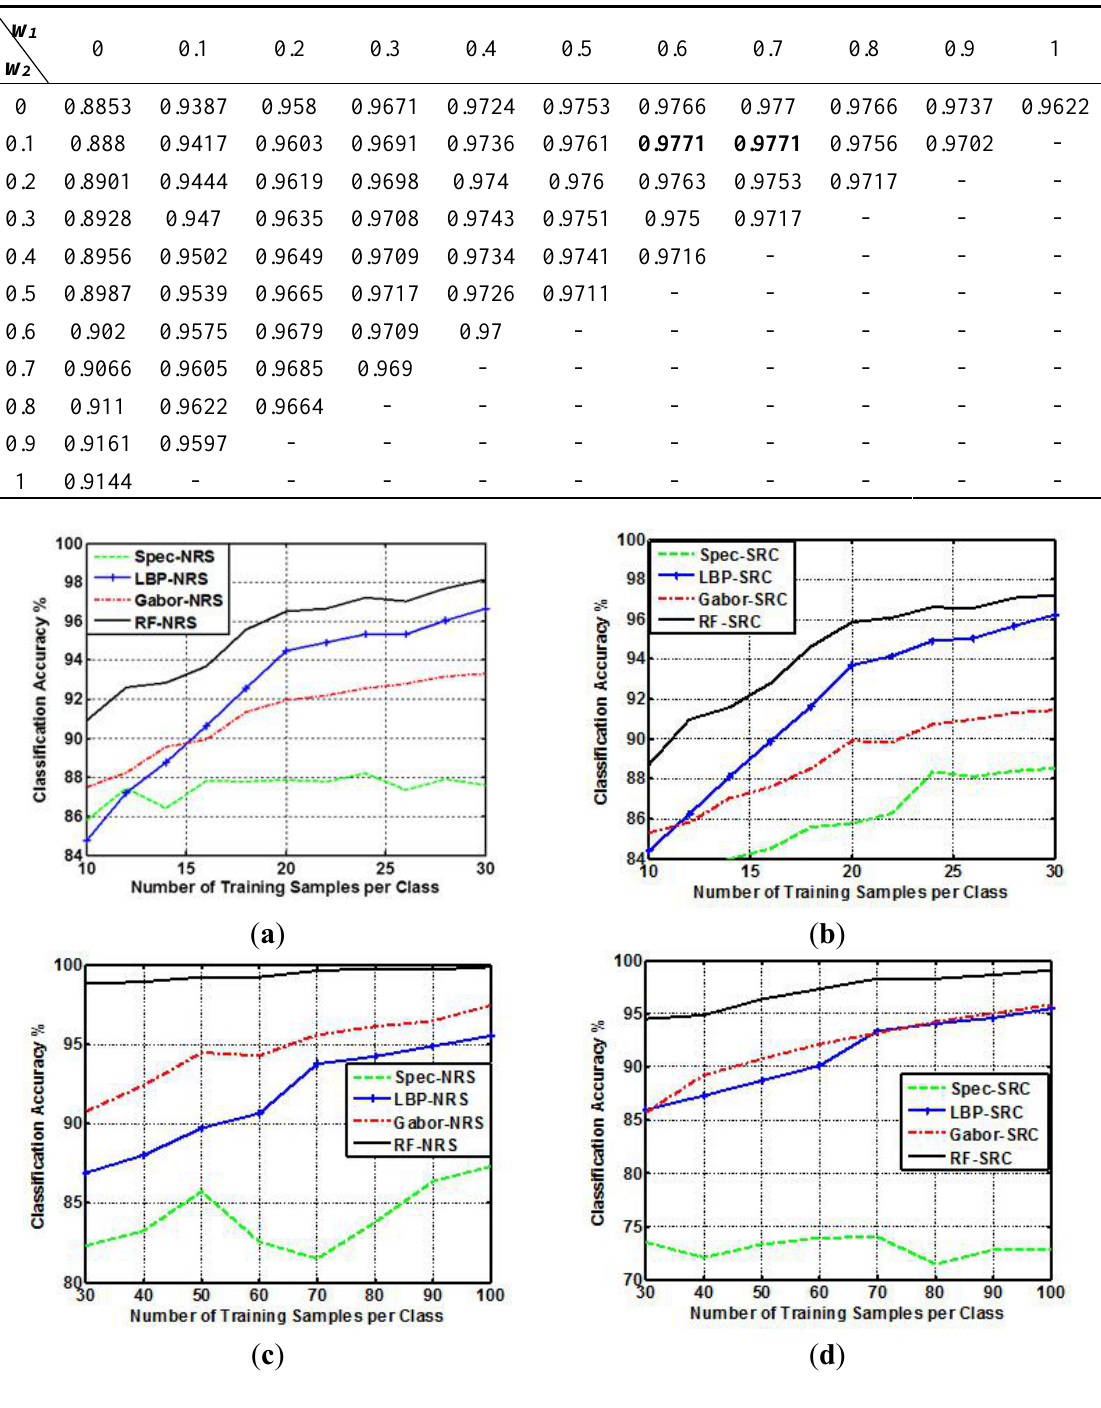
Figure 7. Classification accuracy (%) versus different numbers of training samples per class for two experimental datasets: ( a ) and ( b ) Salinas Valley dataset; ( c ) and ( d ) University of Pavia